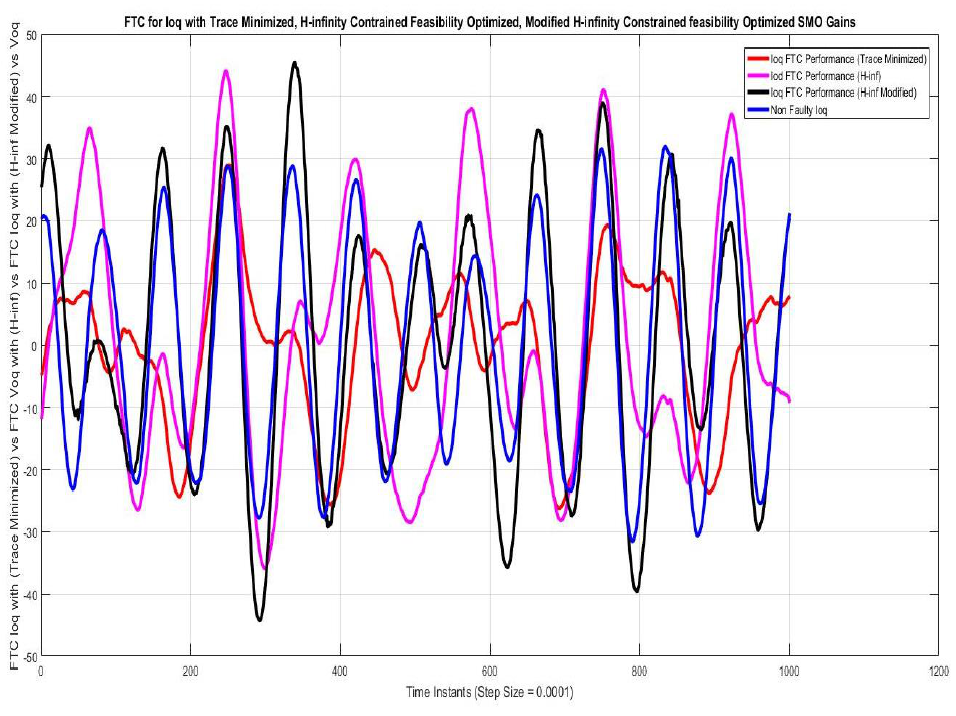
Figure 13. FTC performance for q-component of output current.